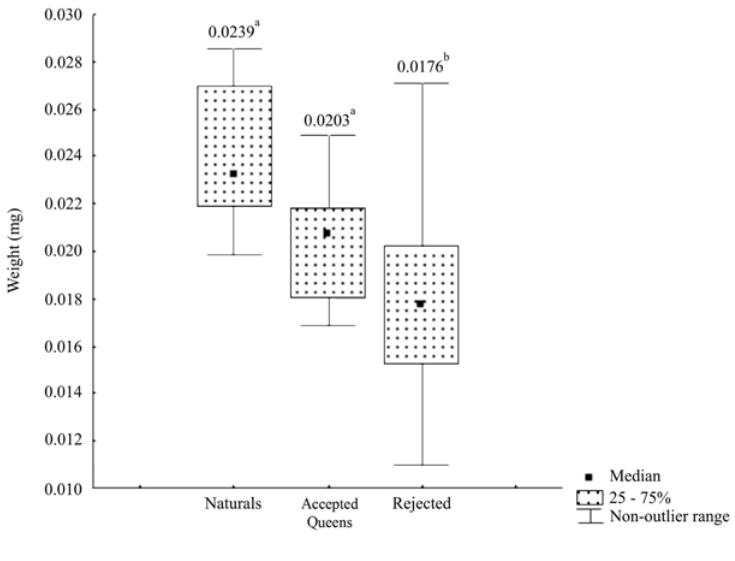
Fig. 5 . Comparison between the weight (mg) of queens of Frieseomelitta varia produced under natural conditions (n=6) and in vitro that were accepted by the workers (n=11), and queens produced in vitro that were rejected and eliminated by the workers (n= 87). a There is no significant difference between the queens’ weight (p=0,083), b there is a significant difference between the queens’ weight